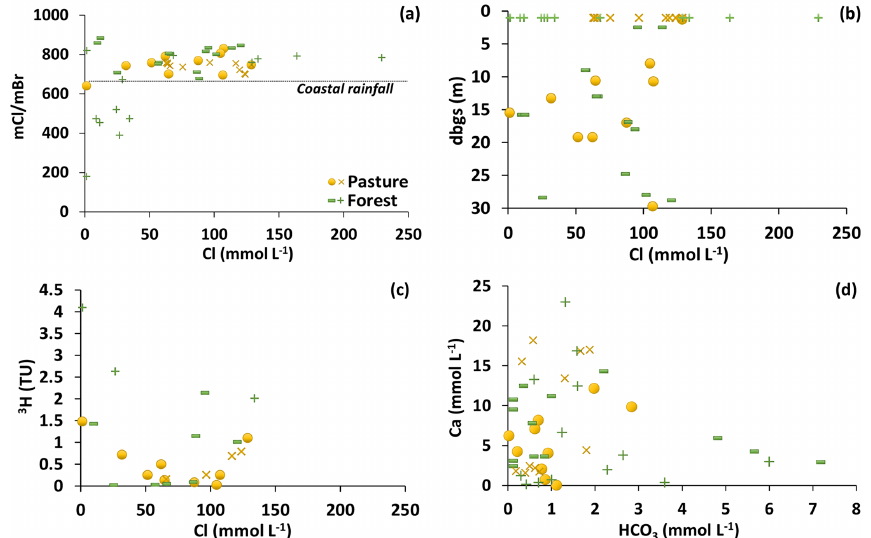
Figure 4. (a) Variations of molar Cl / Br ratios with molar concentrations of Cl. (b) Molar Cl concentrations vs. depth below ground surface (d.b.g.s., m). (c) 3 H (TU) vs. molar Cl concentrations. (d) Molar Ca vs. HCO 3 concentrations. Cross and plus symbols are for the shallow riparian groundwater, and other symbols are for the regional groundwater.